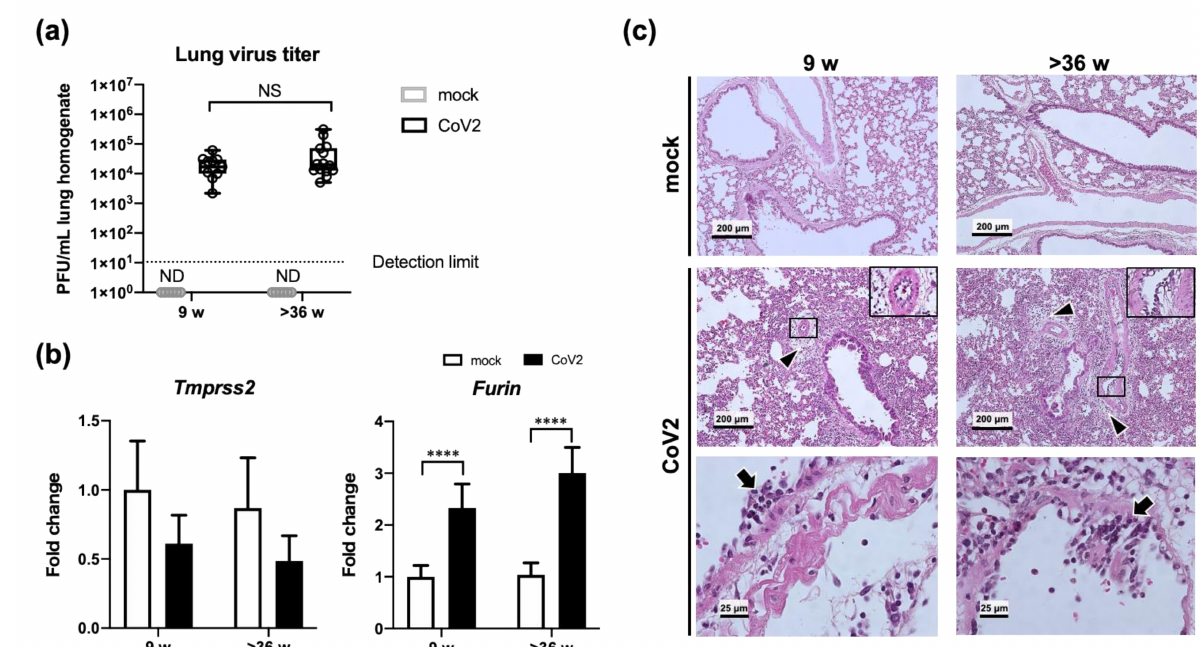
Figure 2. Virus titers and histopathological changes in the lungs of young and aged hamsters. Young (9 w) and aged (>36 w) hamsters were intranasally inoculated with PBS control (mock) or PBS containing SARS-CoV-2 virus (CoV2). Lung samples were collected at 6 days post-infection for the measurement of virus titers ( a ), gene expression analyses ( b ), and histopathological analyses ( c ). ( a ) Plaque assays on Vero-TMPRSS2 cells were performed to calculate the lung virus titers in each sample. Values are represented by box-and-whisker plots as follows: the central line in the box is the median, the bottom and top lines of the box are the first and third quartiles, respectively, whiskers are the minimum to maximum values. Gray and black boxes indicate data from mock and CoV2-infected hamsters, respectively. Each dot indicates data for each animal [mock (9 w), n = 6; CoV2 (9 w), n = 11; mock (>36 w), n = 6; CoV2 (>36 w), n = 14]. No significant difference was detected between young and aged hamsters in each treatment group by two-way ANOVA with Sidak’s multiple comparison test. NS, non-significant; ND, not detected. ( b ) Gene expression levels of transmembrane protease, serine 2 ( Tmprss2 ) and Furin are presented as the fold changes relative to those of young mock hamsters. Bars represent the mean ± SEM [mock (9 w), n = 6; CoV2 (9 w), n = 11; mock (>36 w), n = 6; CoV2 (>36 w), n = 14]. White and black bars indicate data from control and CoV2-infected hamsters, respectively. **** p < 0.0001, two-way ANOVA on dCt values with Sidak’s multiple comparison test. ( c ) For histopathological analyses, sections were stained with hematoxylin and eosin (HE). Arrowheads indicate leukocytes in the perivascular area. Inserts show swelling and detachment of vascular endothelial cells from the underlying basement membrane. Arrows indicate virus infection-induced vasculitis evident by leukocyte infiltration in the tunica intima and the tunica